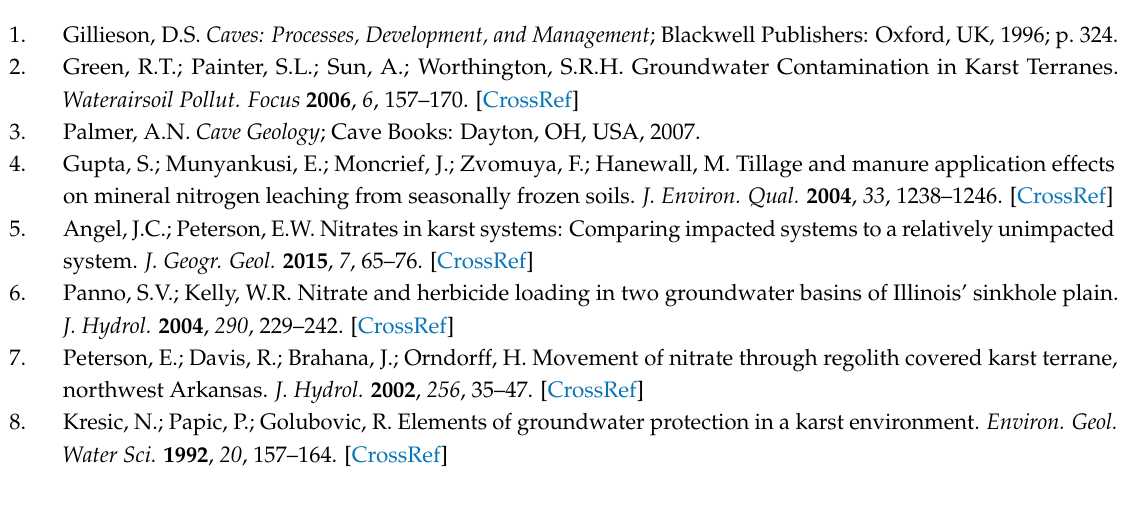
Table S1: Field and laboratory measurements for East Canyon Rd. Table S2: Field and laboratory measurements for West Canyon Rd. Table S3: Field and laboratory measurements for Mahoney. Table S4: Field and laboratory measurements for Cemetery. Table S5: Field and laboratory measurements for North Quarry Rd. Table S6: Field and laboratory measurements for South Quarry Rd. Table S7: Field and laboratory measurements for Cora spring. Table S8: Field and laboratory measurements for Heller spring. Table S9: Field and laboratory measurements for Holesinger spring. Table S10: Field and laboratory measurements for McPhillips spring. Table S11: Field and laboratory measurements for Sargent spring. Figure S1. Box and whisker plots for the 16 water quality parameters measured at the individual streams and